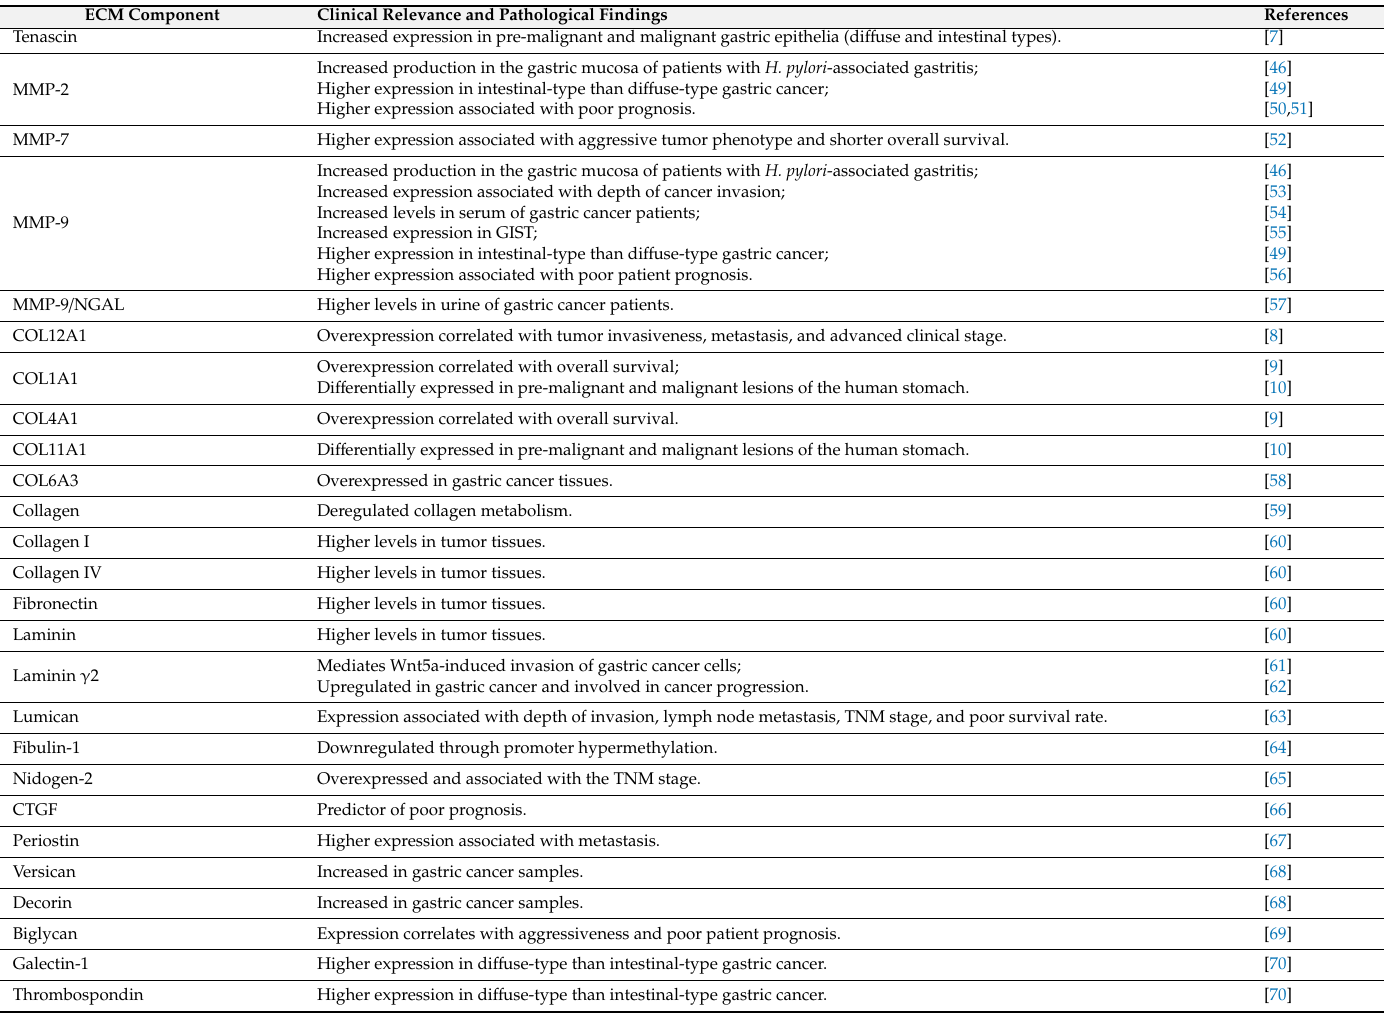
Table 1. ECM components deregulated in gastric cancer. ECM proteins displaying abnormal expression patterns in gastric cancer and associated clinical observations. ECM